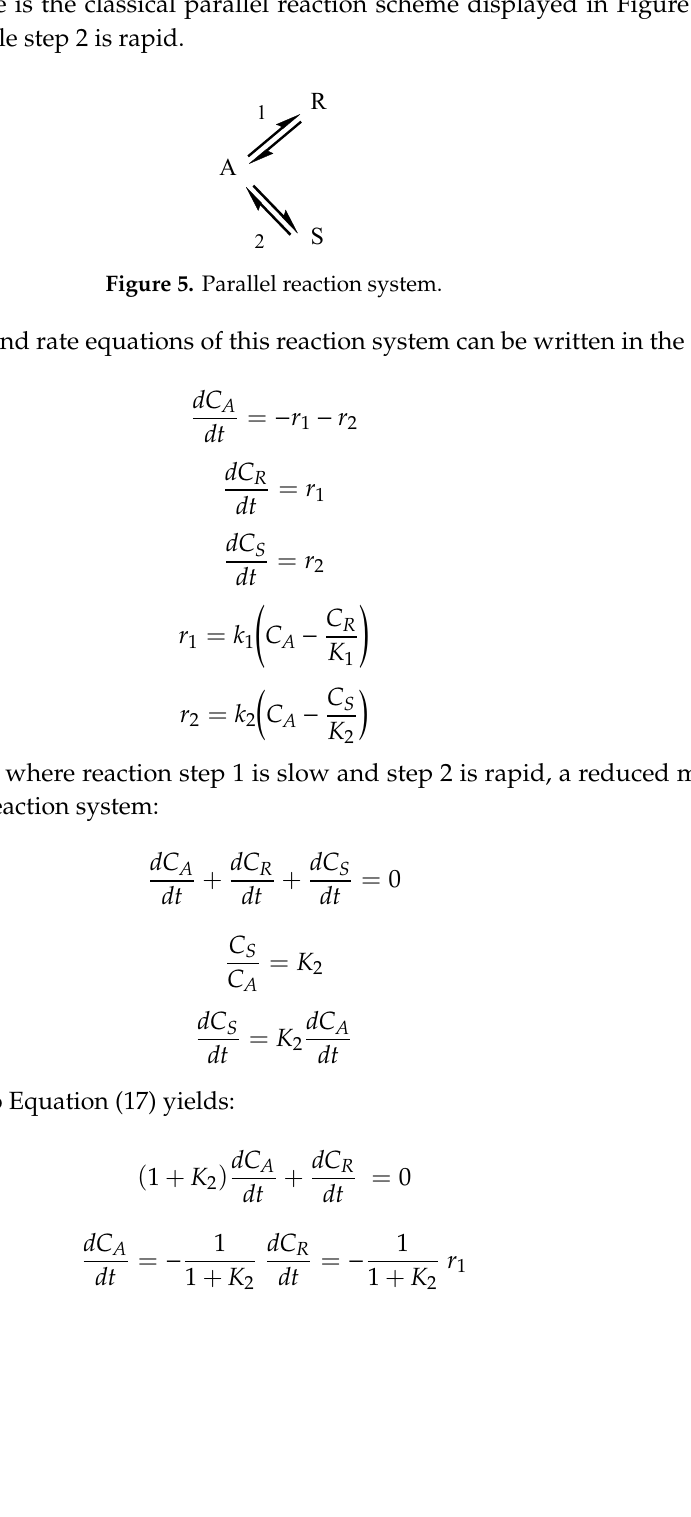
Figure 4. Sum of squared residuals as a function of the rate parameter k 2 of the rapid reaction step 2 in the general case of consecutive reaction system compared to the special case ( k 1 = 1, K 1 = 10 and K 2 = 10).